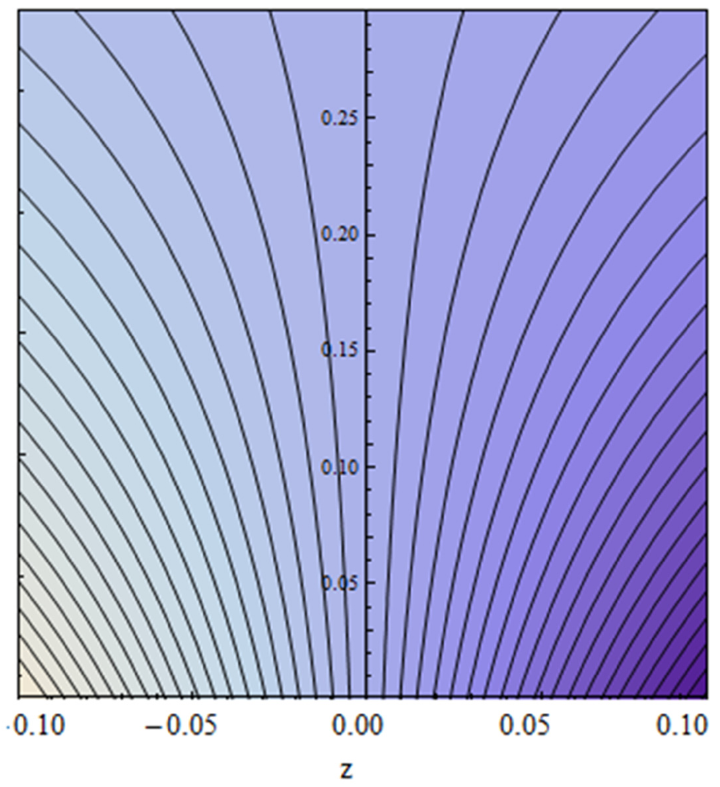
Figure 21. Streamlines impact at Br = 0.5 for the Reynolds model.